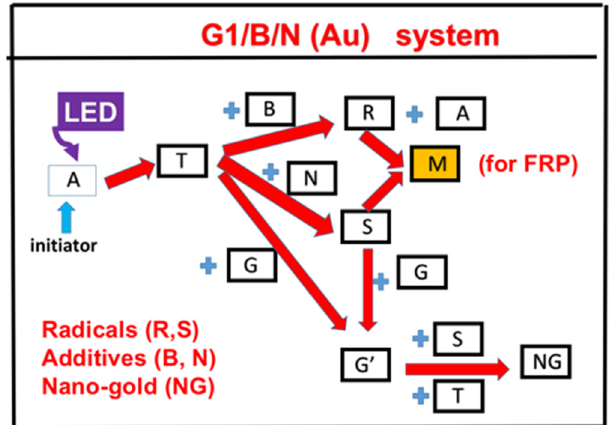
Figure 1. The schematics of a 3-component system, (A/B/N), where A is the ground state of initiator- A, having an excited triplet state T, which interacts with additives [B] and [N} to produce radicals R and S, which can interact with the monomer (for FRP), or interact with the gold (G, or Au +3 ) to produce exited-gold (G’, or Au +2 and Au +1 ), which then further couples with T and S, leading to the formation of nanogold (NG, or Au 0 ) in the polymer